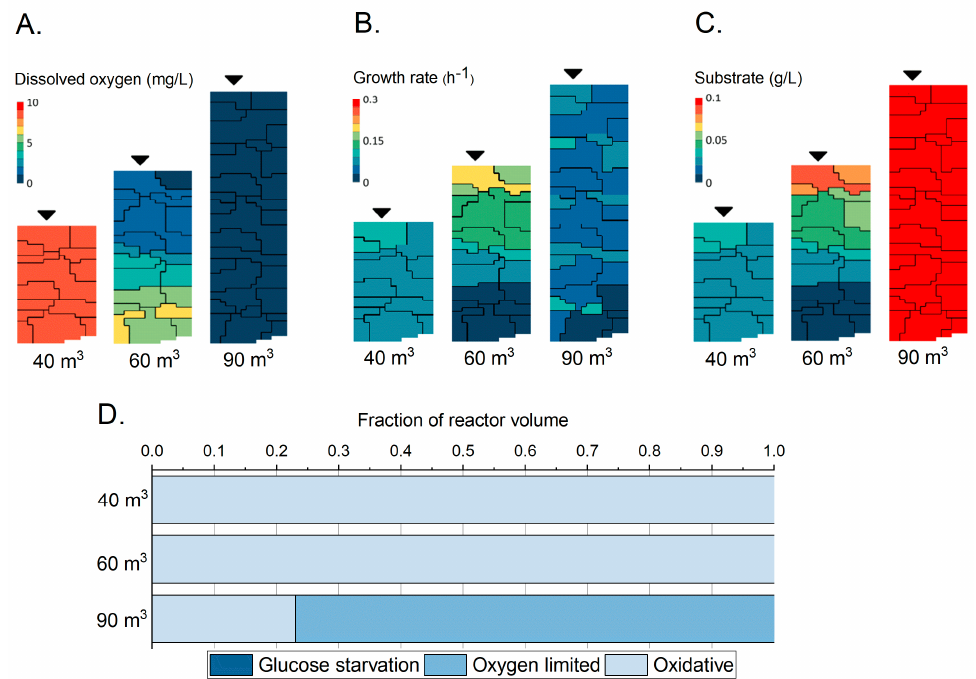
Figure 3. Overview of industrial-scale bioreactor conditions and metabolic regimes. ( A ) Simulated compartmental overview of the dissolved oxygen (mg/L) concentrations in three large-scale liquid volume conditions. ( B ) Simulated compartmental overview of the growth rate (h − 1 ). ( C ) Simulated compartmental overview of the substrate concentrations (g/L). ( D ) Expected metabolic regimes as a fraction of the total bioreactor volume.